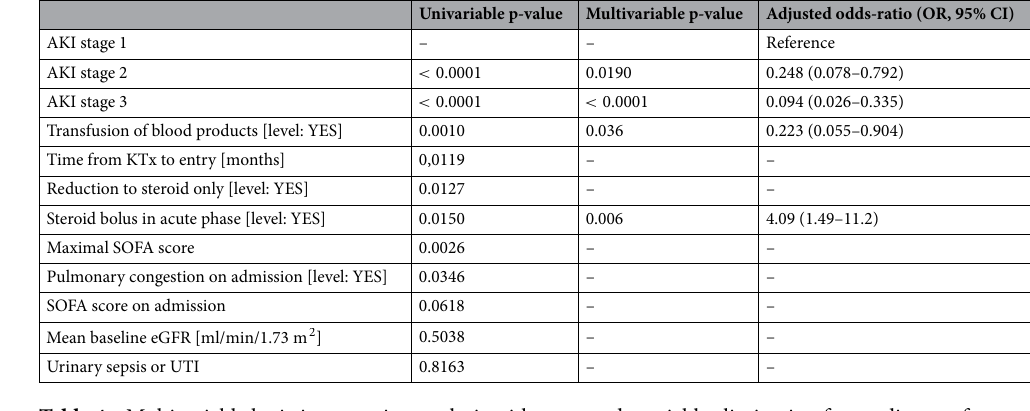
Table 4. Multivariable logistic regression analysis with retrograde variable elimination for predictors of recovery from UTI-AKI at 1-month post-discharge.